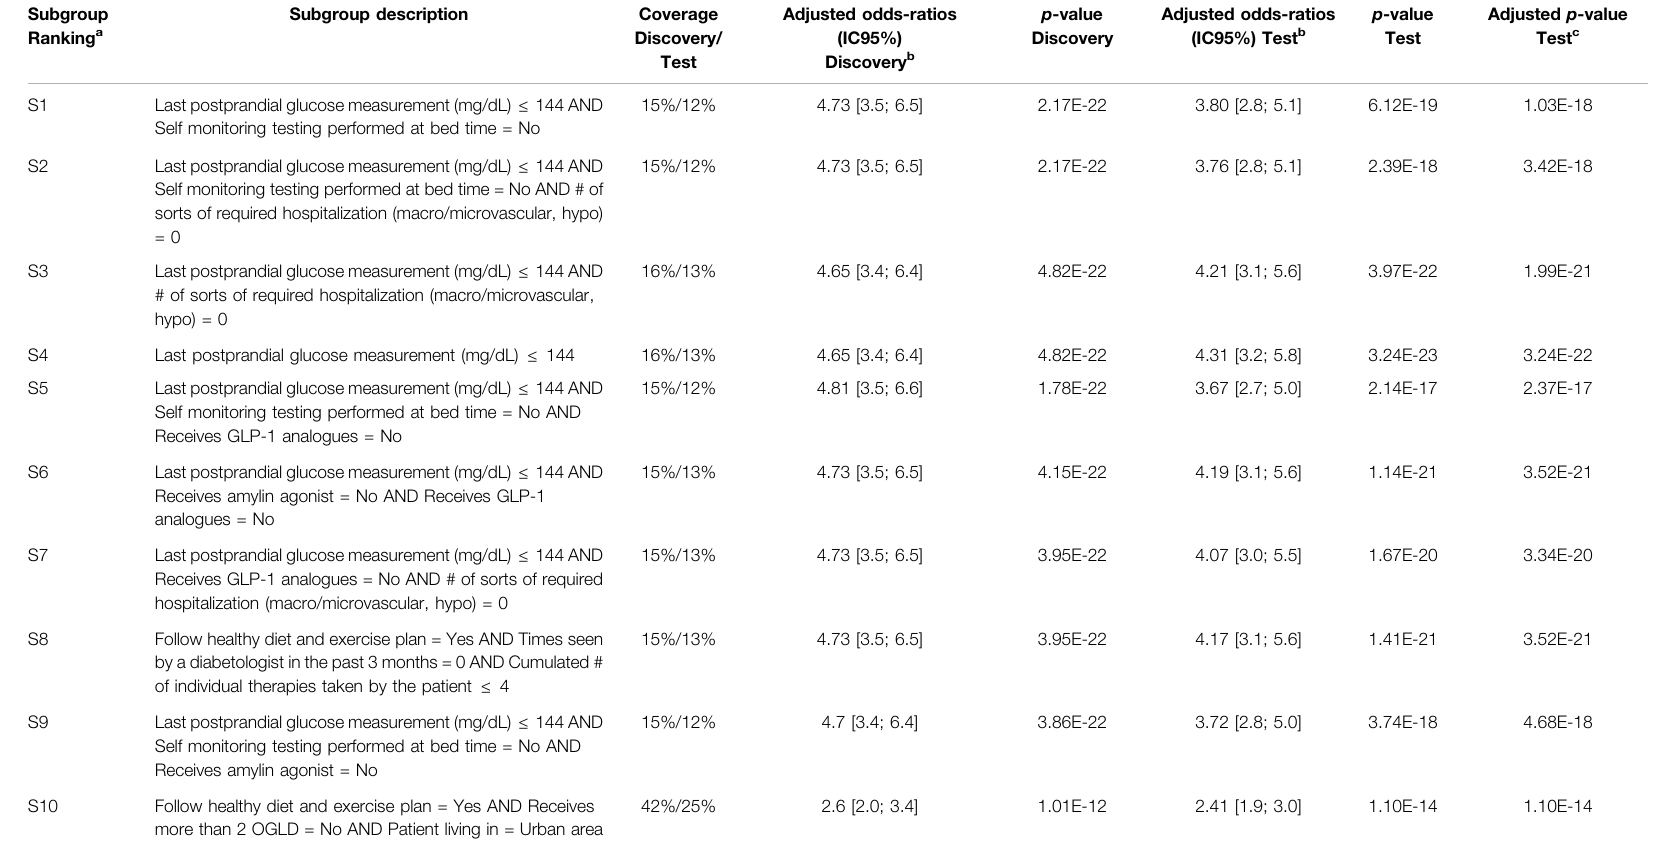
TABLE 5 | Credibility metrics from literature (used in Q-Finder) computed on APRIORI-SD